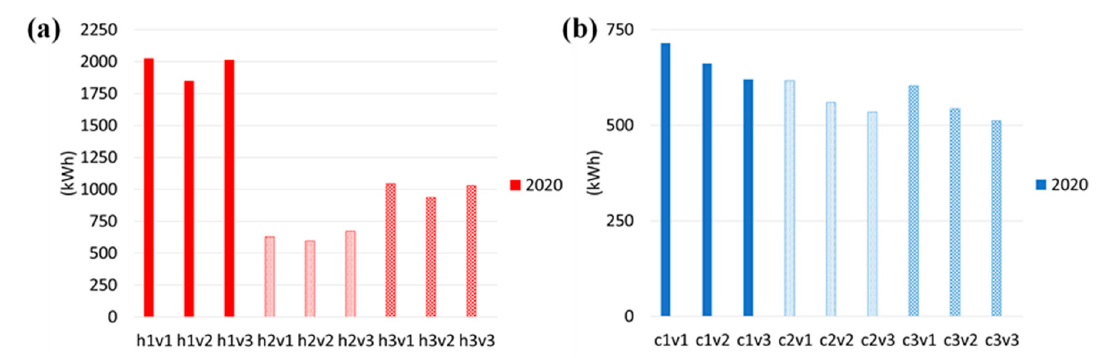
Figure 7. Energy needs in the current climate for: ( a ) the heating season; ( b ) the cooling season.